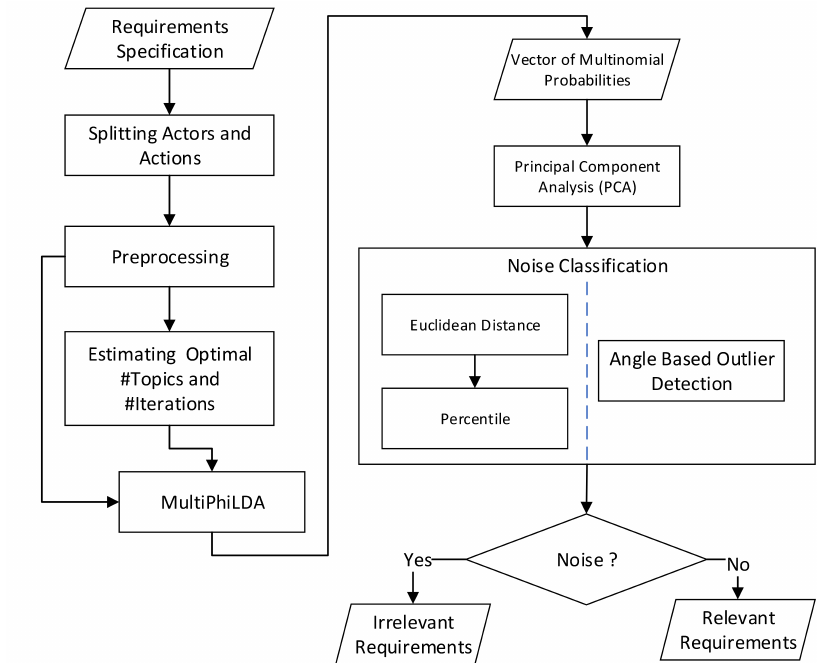
Figure 1. The noise detection